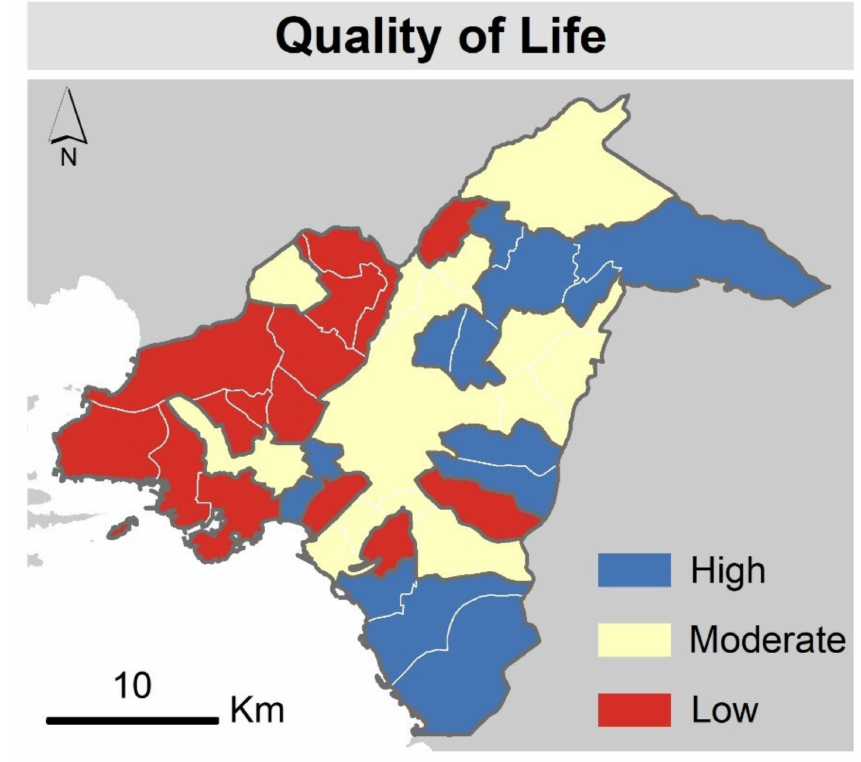
Figure 6. The final QoL map for AMA,